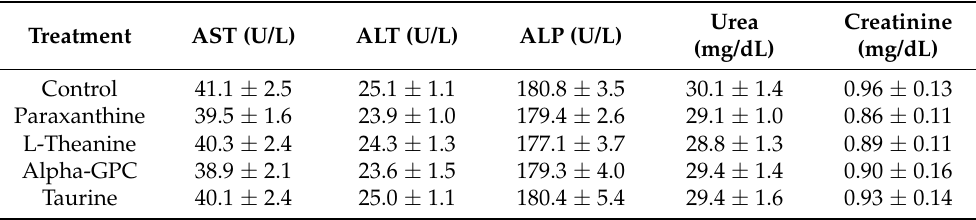
Table 4. Plasma levels of aspartate aminotransferase (AST), alanine aminotransferase (ALT) alkaline phosphatase (ALP), urea, and creatinine after 28 days of treatment. Treatment AST (U/L)